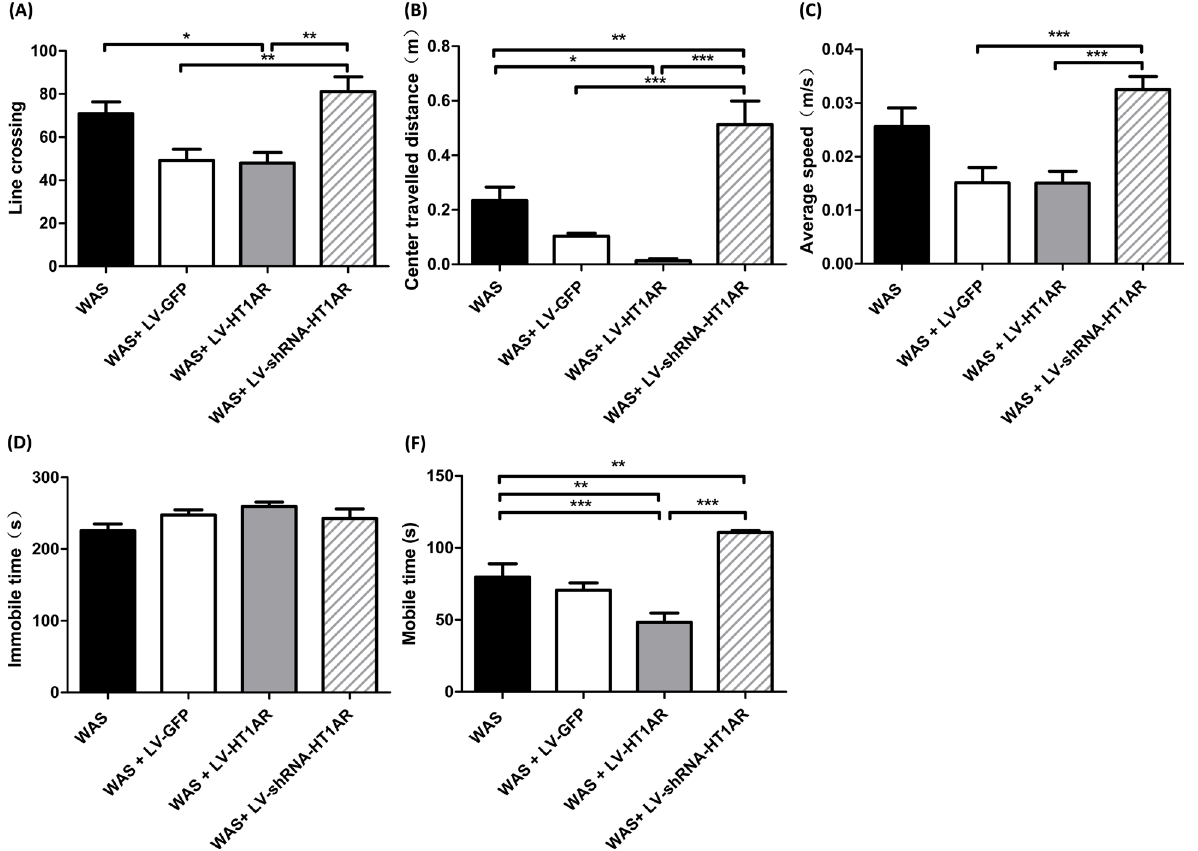
Figure 2: Effects of bilateral ACC lentivirus intervention on OFT behaviours. The number of line crossings (A), center travelled distance (B), average speed (C) , immobile time (D) and mobile time(F) in the OFT were analyzed and compared among different groups. Data are presented as means±SEM. n=10, *, P<0.05, **, P<0.01, ***, P<0.001, calculated by one-way ANOVA with post-hoc